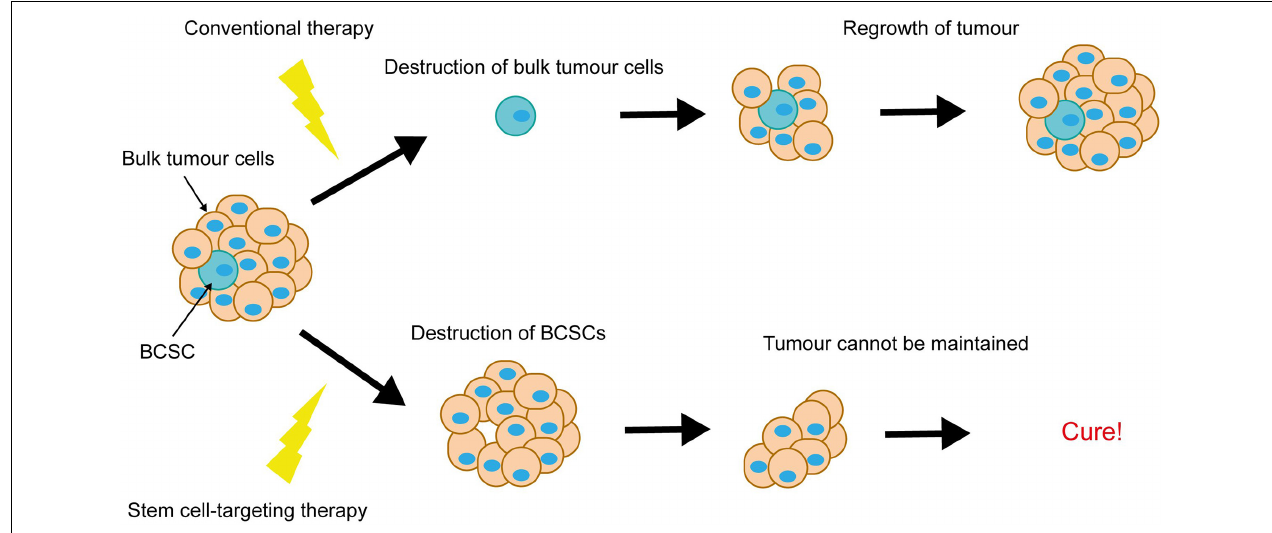
FIGURE 6 | Elimination of breast cancer stem cells is key to achieving complete tumour regression. Conventional therapies destroy the bulk tumour cells, causing tumour regression, however resistant BCSCs survive and re-populate the tumour. Elimination of the BCSCs (even without immediate destruction of the bulk tumour cells) could induce complete tumour regression, as the tumour cells die off and are not